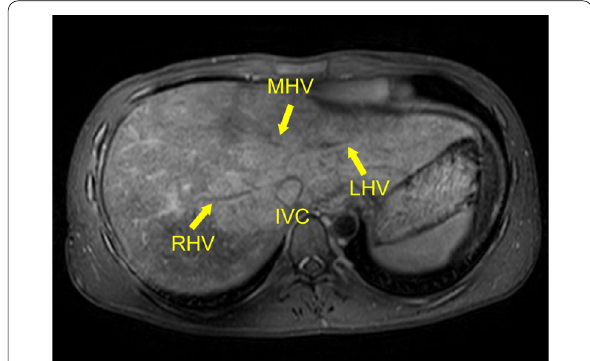
Fig. 2 Preoperative abdominal magnetic resonance imaging (MRI) showing obstructed and scarred main hepatic veins. Abbreviations: IVC, inferior vena cava; LHV, left hepatic vein; MHV, middle hepatic vein; RHV, right hepatic